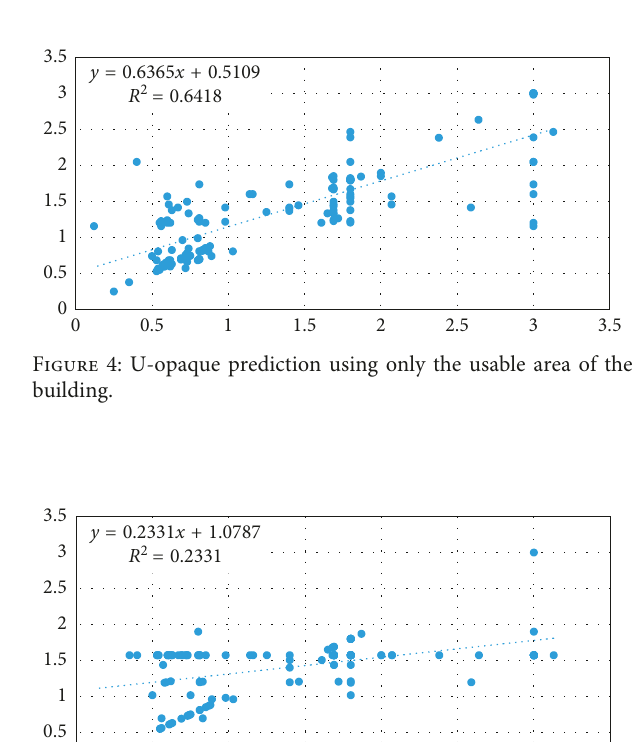
Figure 3: U-opaque prediction using only the year of construction of the building.